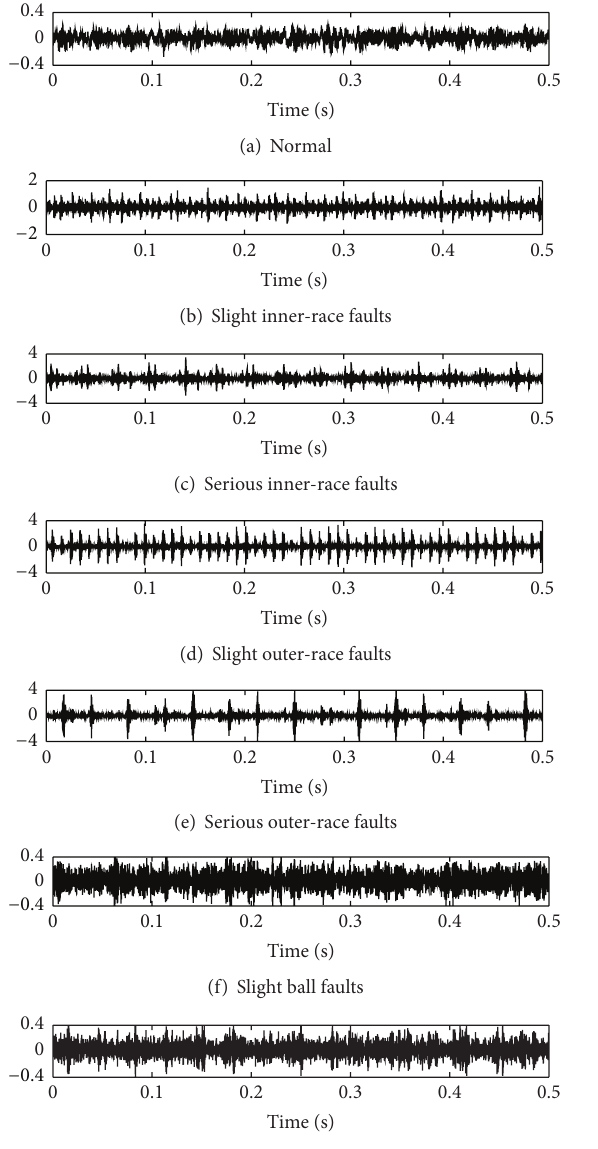
Figure 5: The waveforms of seven vibration signals (ordinate unit: m/s 2 ).